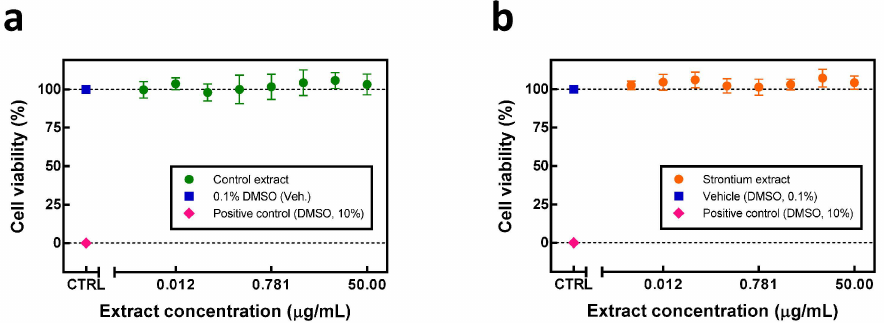
Figure 3. Dose-response effect of extracts from control and strontium-stimulated soybeans on viability of HepG2 liver cells assessed using tetrazolium reduction assay. The cells were treated with vehicle (DMSO, 0.1%) or with increasing concentrations of shoot extracts from ( a ) control and ( b ) 2 mM Sr 2+ -stressed soybeans. Ten percent solution of DMSO was used as a positive control for cytotoxicity. Viability of vehicle-treated cells was set at 100. Data show the average ˘ SD of three independent experiments, each performed in triplicate